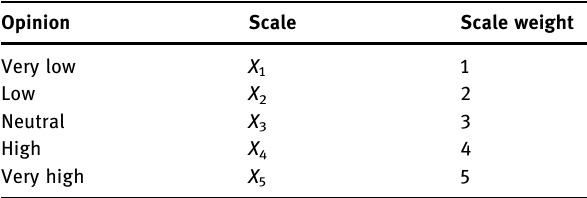
Table 1: Weights based on the Likert quintet